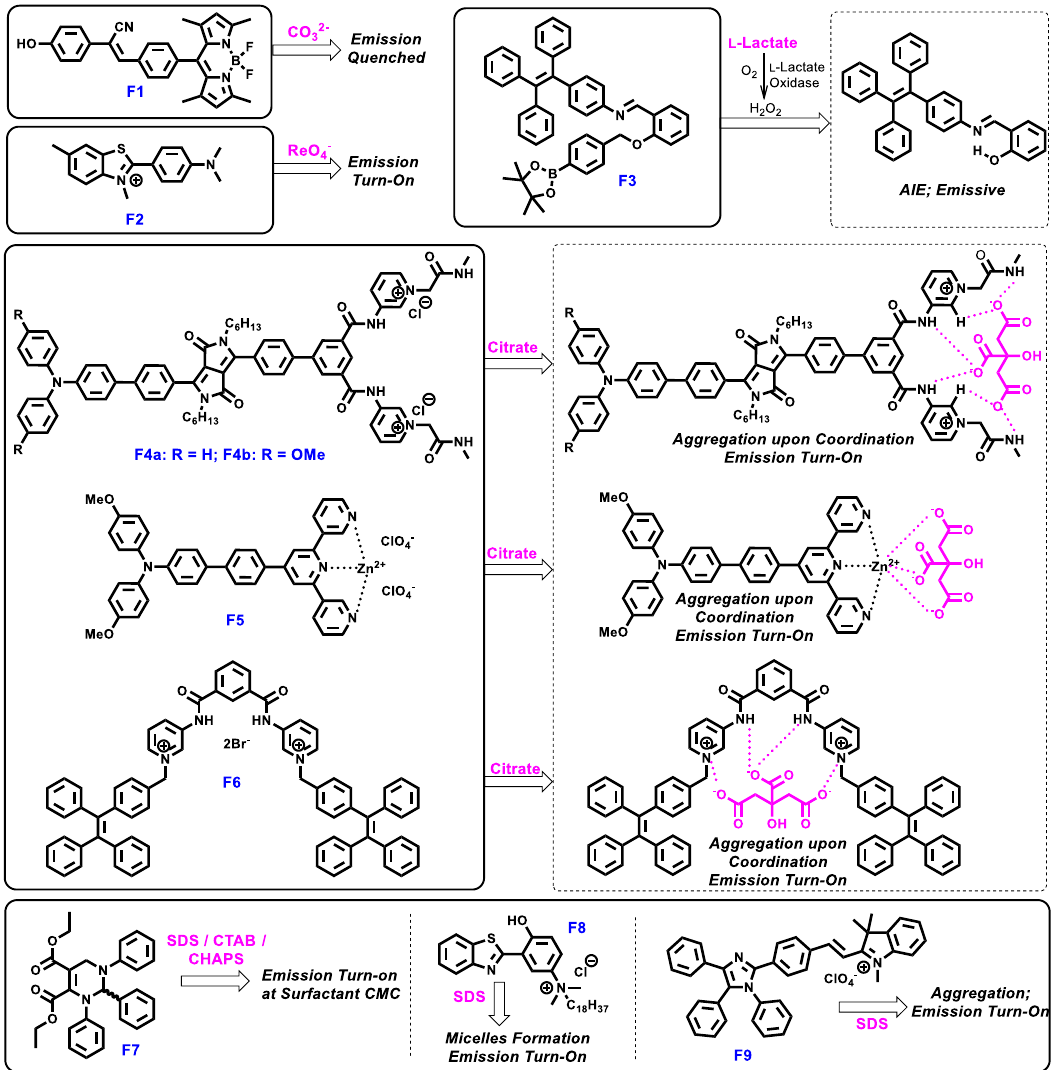
Scheme 11. Chemical structures and detection mode of AIE-based chemosensors for the sensing of